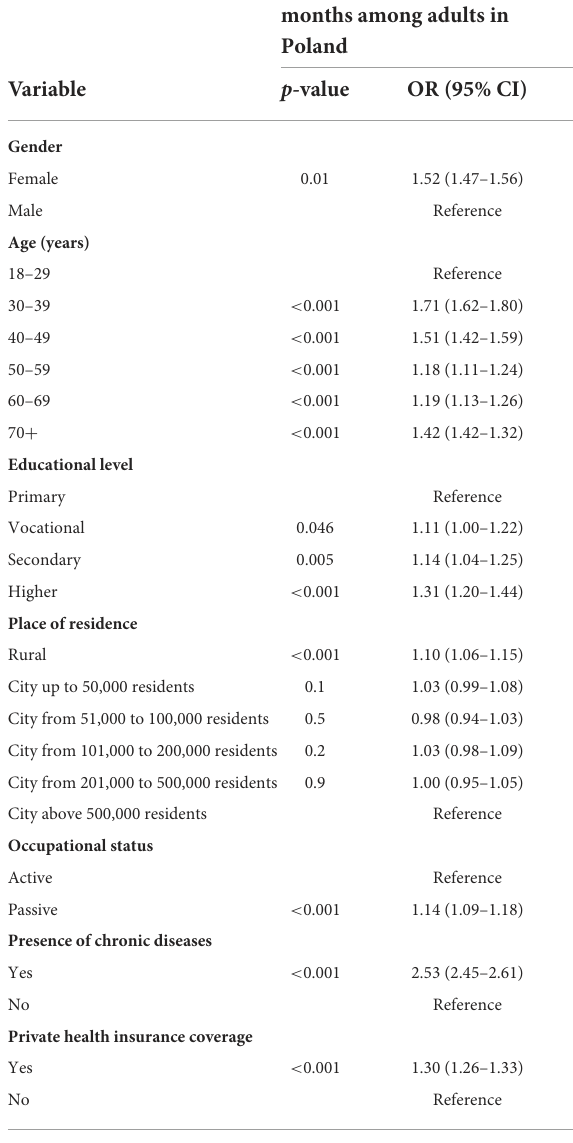
TABLE 3 Factors associated with the use of health services in the past 12 months among adults in Poland ( n = 102,928) - multivariable logistic regression